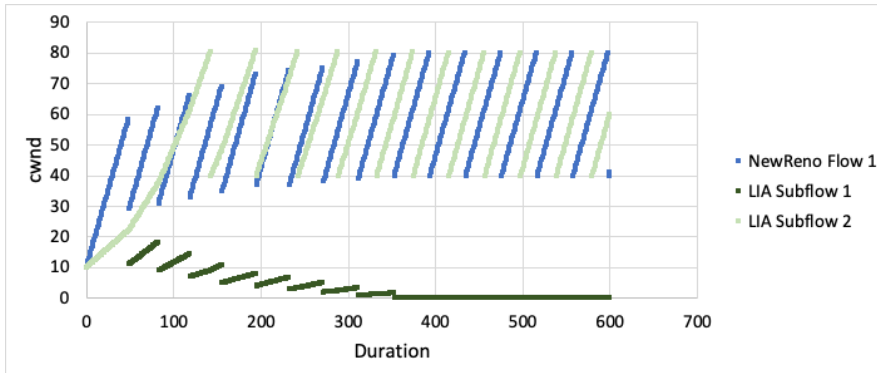
Figure 9. LIA—Competing Window Growth—Same RTT.